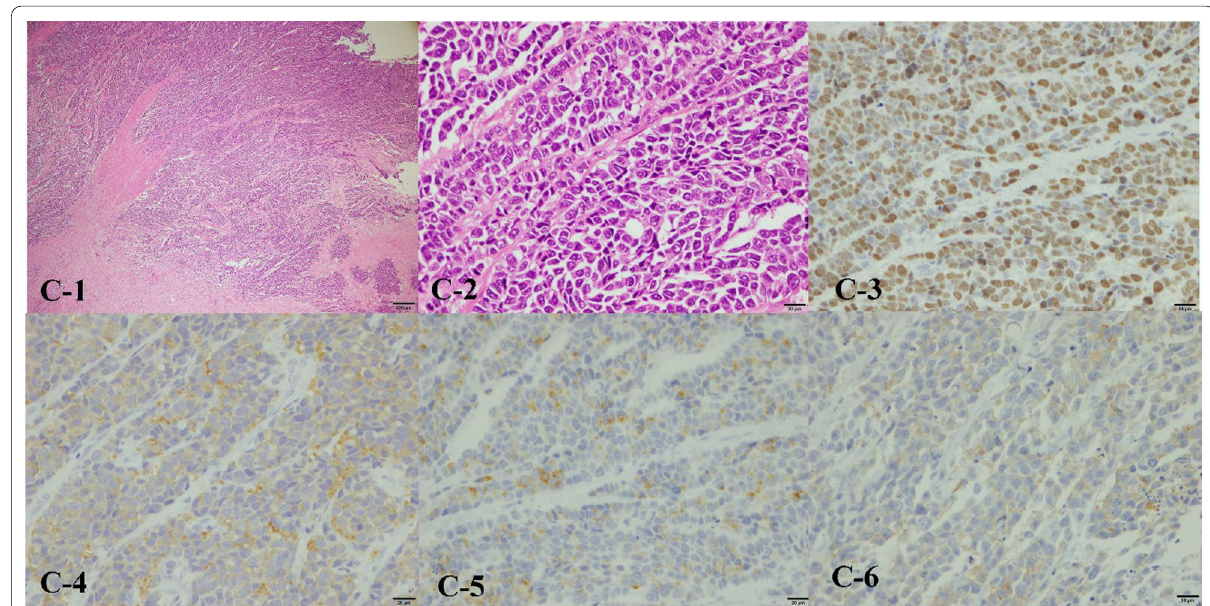
Fig. 3 Pathological analysis. c-1-2 Greatly increased anisonucleosis and a high mitotic index were observed by H&E staining. A partial cord-like sequence was observed. c-3 Ki-67 was more than 70% positive. c-4 Synaptophysin was positive by immunostaining. c-5 Chromogranin A was positive by immunostaining. c-6 CD 56 was positive by immunostaining